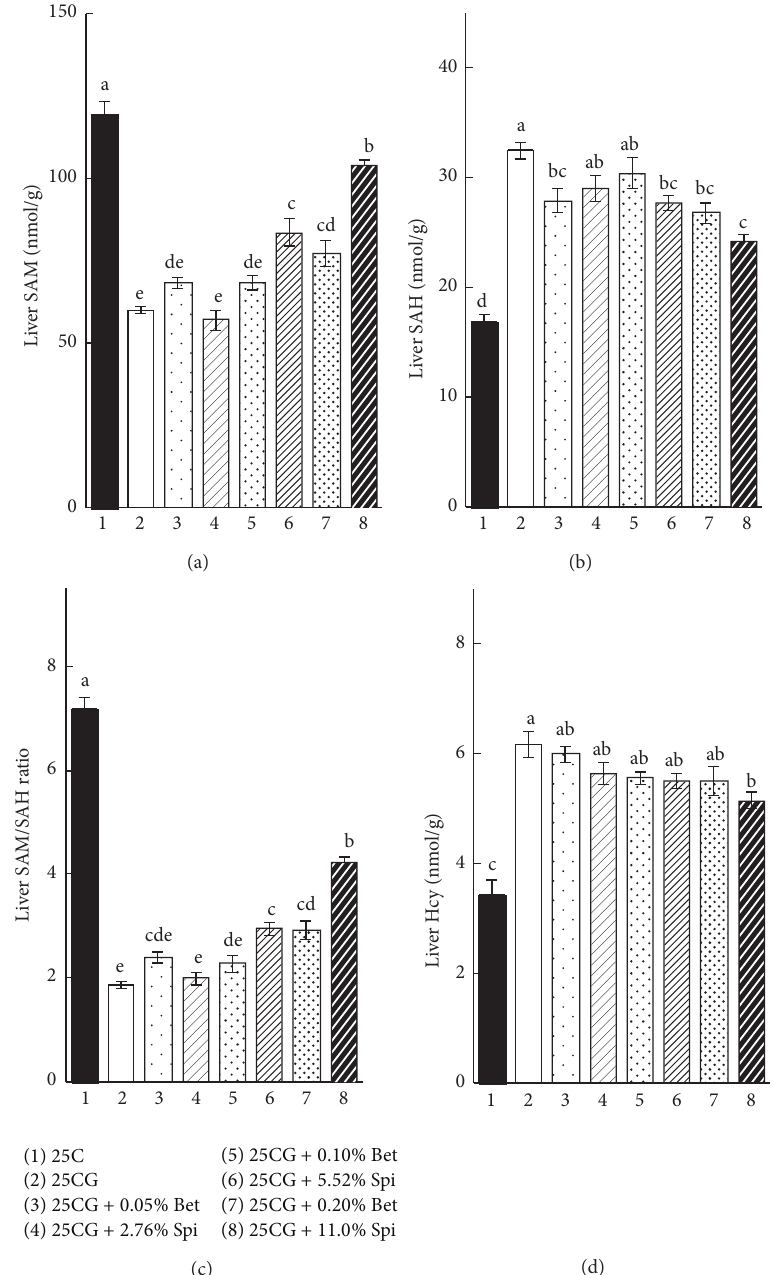
Figure 3: Hepatic concentrations of S-adenosylmethionine (a) and S-adenosylhomocysteine (b), their ratio (c), and homocysteine (d) in rats fed the experimental diets (experiment 1). Each value is the mean ± SEM, 𝑛 = 8 . Values in a panel without a common letter differ at 𝑃 < 0.05 .